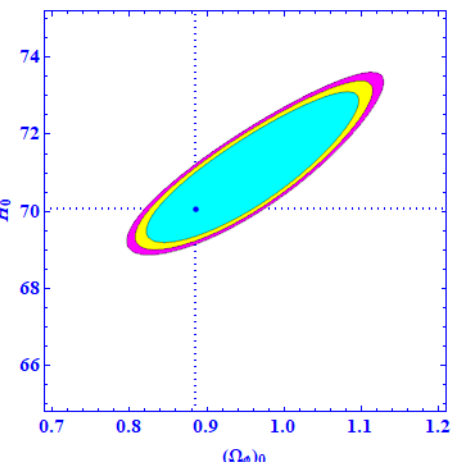
Figure 3. Two-dimensional contours in the ( Ω φ ) 0 − ( ω φ ) 0 plane at 1 σ , 2 σ and 3 σ confidence regions by bounding our model with joint H ( z ) and pantheon compilation of SN Ia data.